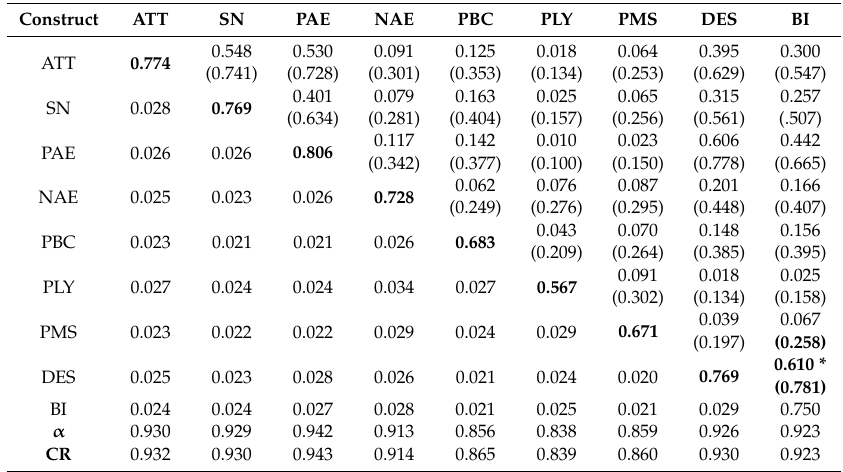
Table 3. Results of measurement model.